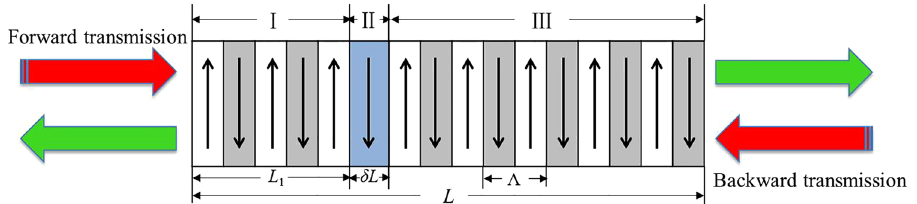
Figure 1. A schematic of the forward and backward SHG processes in a 1D nonlinear photonic crystal with a defect